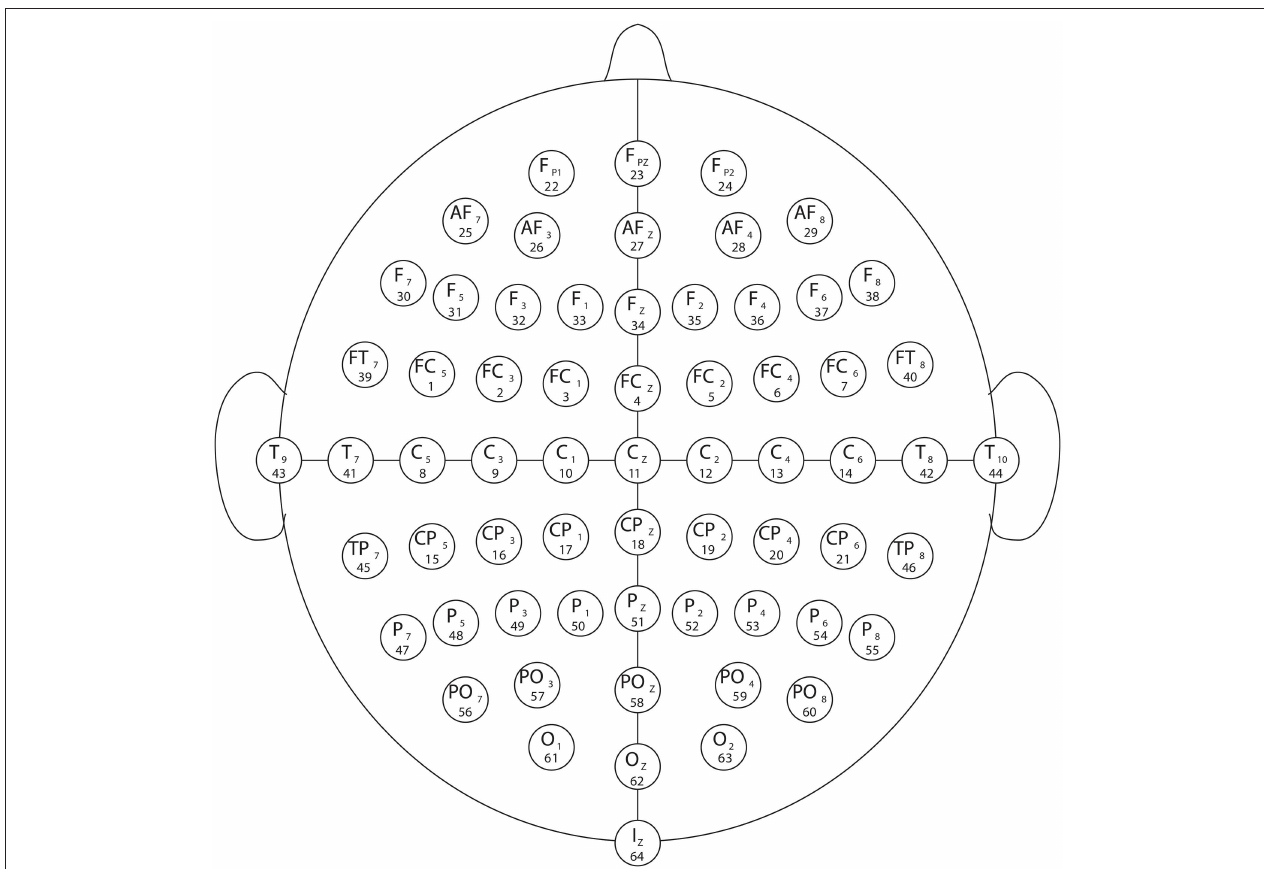
FIGURE 1 | Electrode arrangement as per the international 10–20 system (as in [12, 41–43, 45, 61–63]). The numbers below each electrode name indicate the order in which they appear in the recordings.